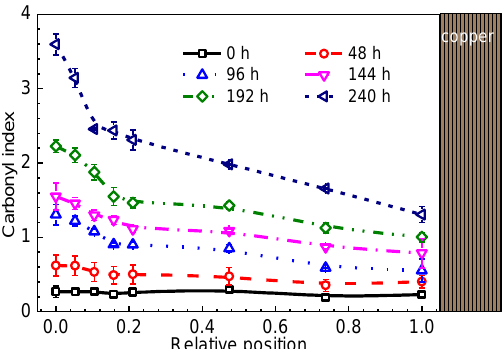
Figure 8. Profile of carbonyl index for different XLPE samples.